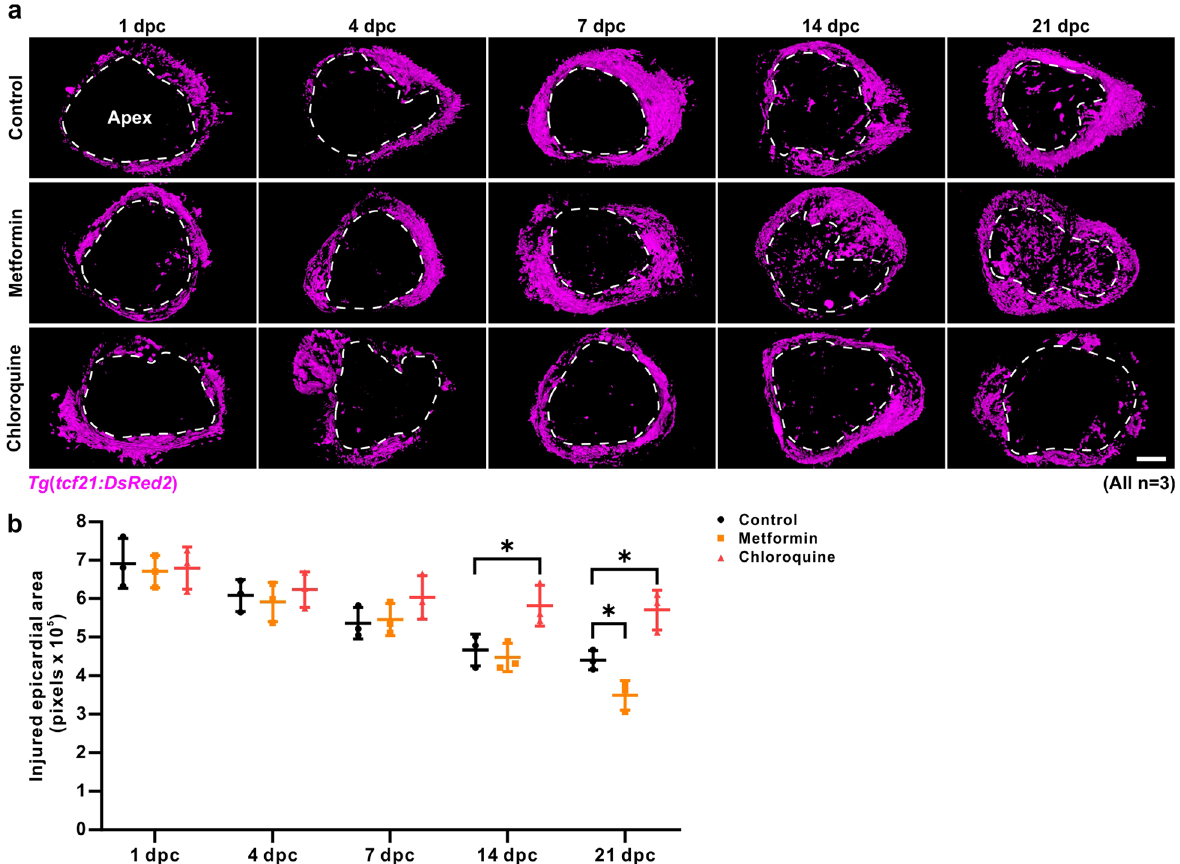
Fig. 5 Metformin accelerates regeneration of the epicardium. a After cryoinjury, the Tg ( tcf21:DsRed2 ) line of fi sh, which express DsRed2 (in pink) speci fi cally in the epicardium were maintained in untreated fi sh water (control) or in fi sh water containing 50 µM metformin or 100 µM CQ for 1 – 21 days. The hearts were then isolated and directly embedded in capillaries with 1% low melting agarose gel, after which a Z-stack of frontal view images through the ventricular apex were acquired ex vivo using light sheet fl uorescence microscopy. The Z-stack images were displayed in three dimensions with surface render mode. The dashed line in each image indicates the injured area. Scale bar: 200 µm. b The injured epicardial area of the control, metformin, and CQ-treated fi sh at 1 dpc, 4 dpc, 7 dpc, 14 dpc, and 21 dpc were quanti fi ed. The data are presented as mean ± SD, n = 3 hearts, * P < 0.05 vs